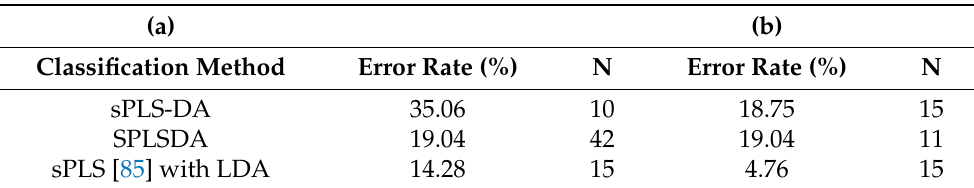
Figure 12. Projection of sensors over the two relevant components (LDA1 and LDA2) from LDA; ( a ) using variables from Method 1, ( b ) Method 2. Three classes were considered according to sensor height (h): class 1 (2.0 4.3), class 2 (4.3 < h 8.7), and class 3 (8.7 < h 13). Red numbers h ≤ ≤ ≤ ≤ correspond to sensors wrongly classified. Table 3. Classification error rate and number of selected variables (N) using sPLS-DA, SPLSDA, and sPLS with LDA. Results are presented according to the method used for computing the features from the time series: ( a ) Method 1 and ( b ) Method